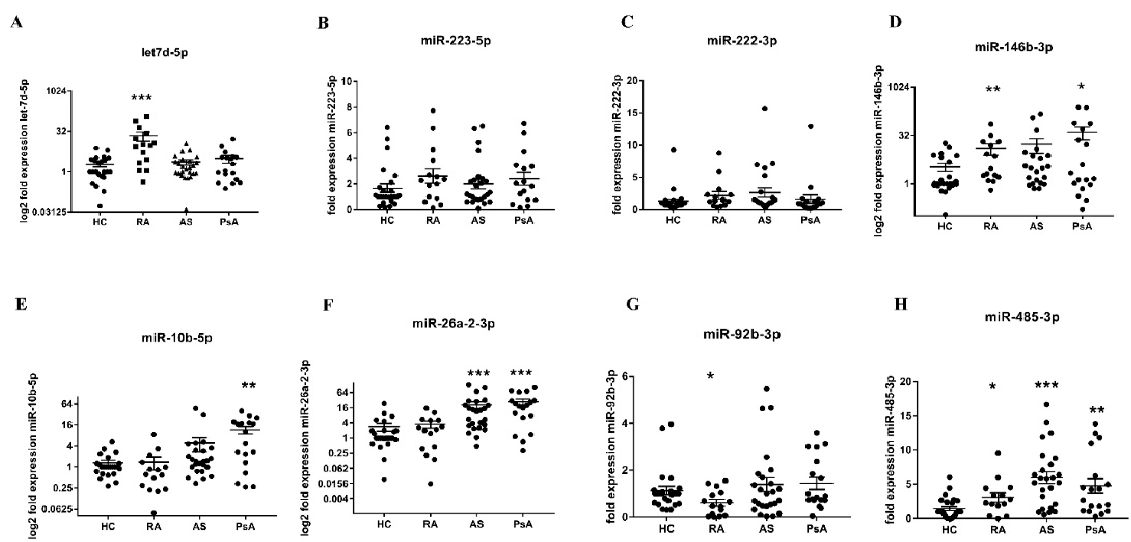
Figure 1. The level of circulating let7d-5p ( A ), miR-223-5p ( B ), miR-222-3p ( C ), miR-146b-3p ( D ), miR-10b-5p ( E ), miR-26a-2-3p ( F ), miR-92b-3p ( G ), and miR-485-3p ( H ). The expression level of sera circulating miRs was measured in HC ( n = 15), RA ( n = 15), AS ( n = 25), and PsA ( n = 18) patients. Results were normalised to the miR-16a internal control. Each symbol represents an individual subject. p -values are expressed as follows: 0.05 > p > 0.01 as *; 0.01 > p > 0.001 as **; p < 0.001 as ***.